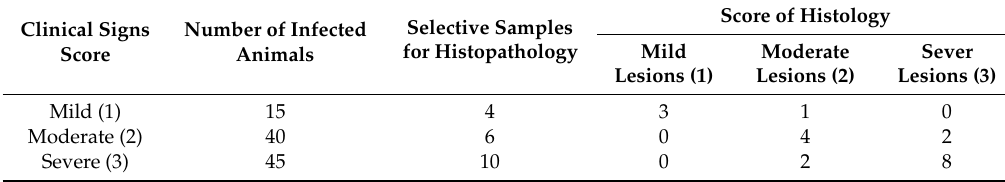
Table 1. Macroscopic and microscopic scoring of infected